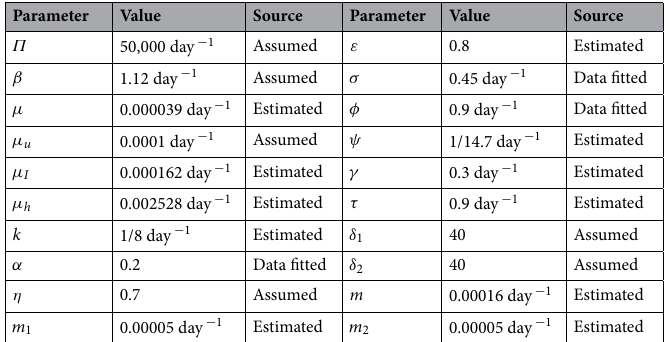
Table 3. Parameters value for the numerical simulations.